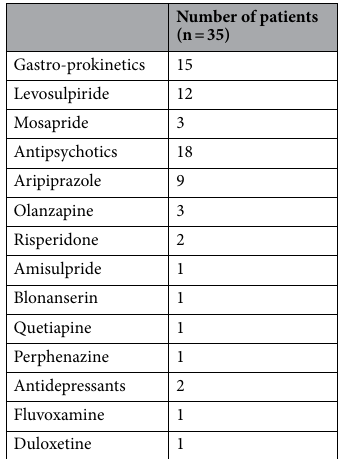
Table 2. Offending drugs in patients with drug-induced parkinsonism.